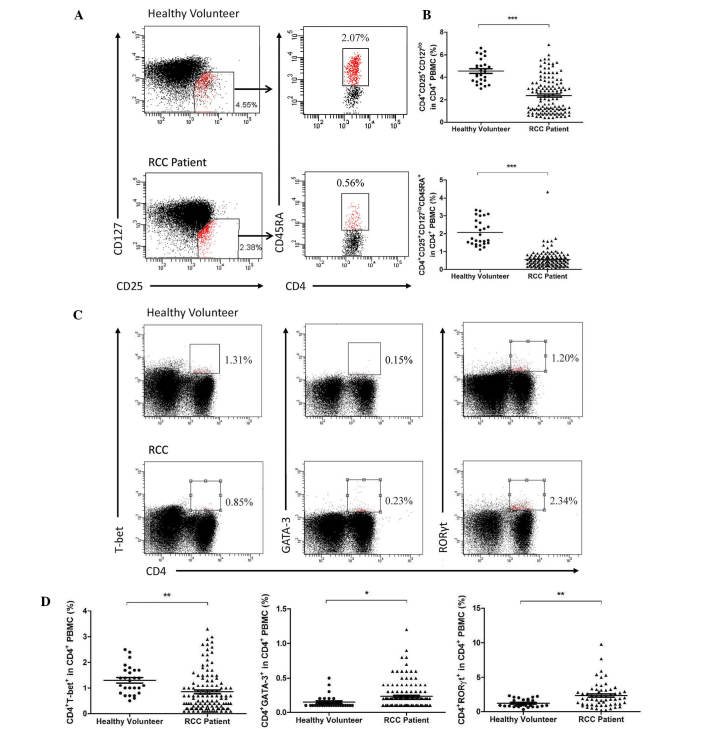
Proportion of Th1/Th2/Th17/Treg cells in CD4+ T cells in PBMCs. (A-C) Activated Treg (CD4+ CD25+ CD127lo), naïve Treg (CD4+ CD25+ CD127lo CD45A+) and Th1 (CD4+ T-bet+) cells were significantly decreased, while (C-D) Th17 (CD4+ RORγt+) and Th2 (CD4+ GATA-3+) cells were significantly increased in RCC patients compared with populations in healthy volunteers. Data are expressed as the mean percentage ± standard error of the mean. Th, T helper; Treg, T regulatory; RCC, renal cell carcinoma; PBMC, peripheral blood mononuclear cell; GATA3, GATA binding protein 3; RORγt, RAR-related orphan receptor γt. *P<0.05; **P<0.01; ***P<0.001.